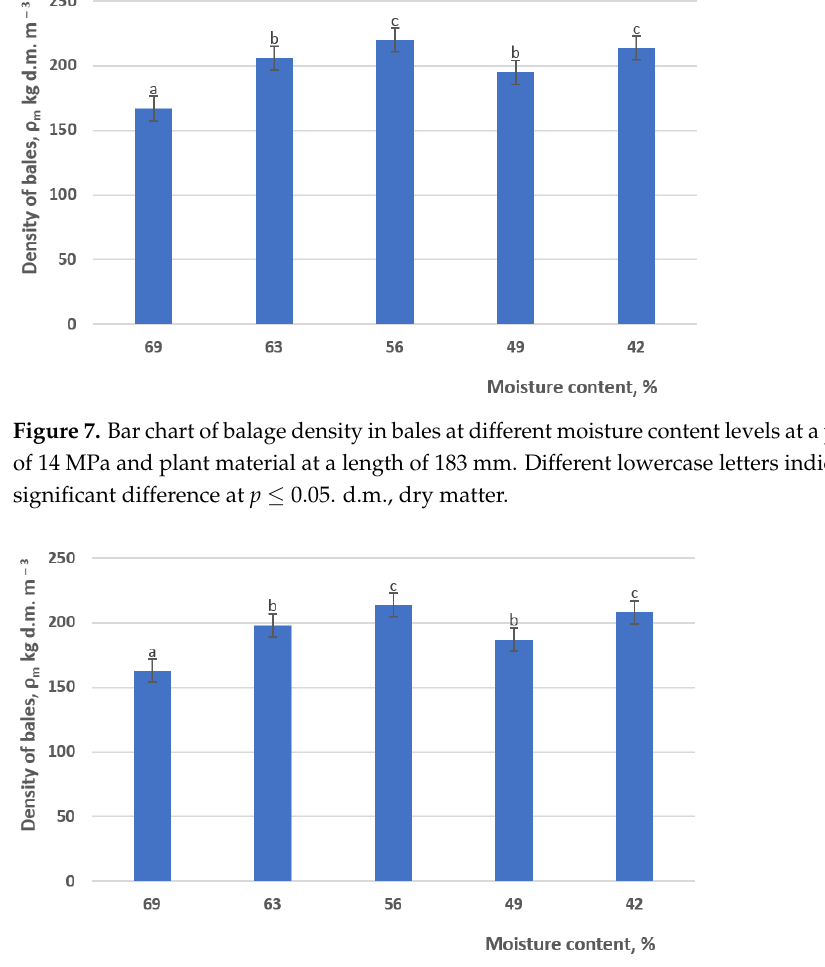
Figure 6. Bar chart of balage density in bales at different moisture content levels at a pressing pres- sure of 18 MPa and plant material at a length of 183 mm. Different lowercase letters indicate a sta- tistically significant difference at p ≤ 0.05. d.m, dry matter.